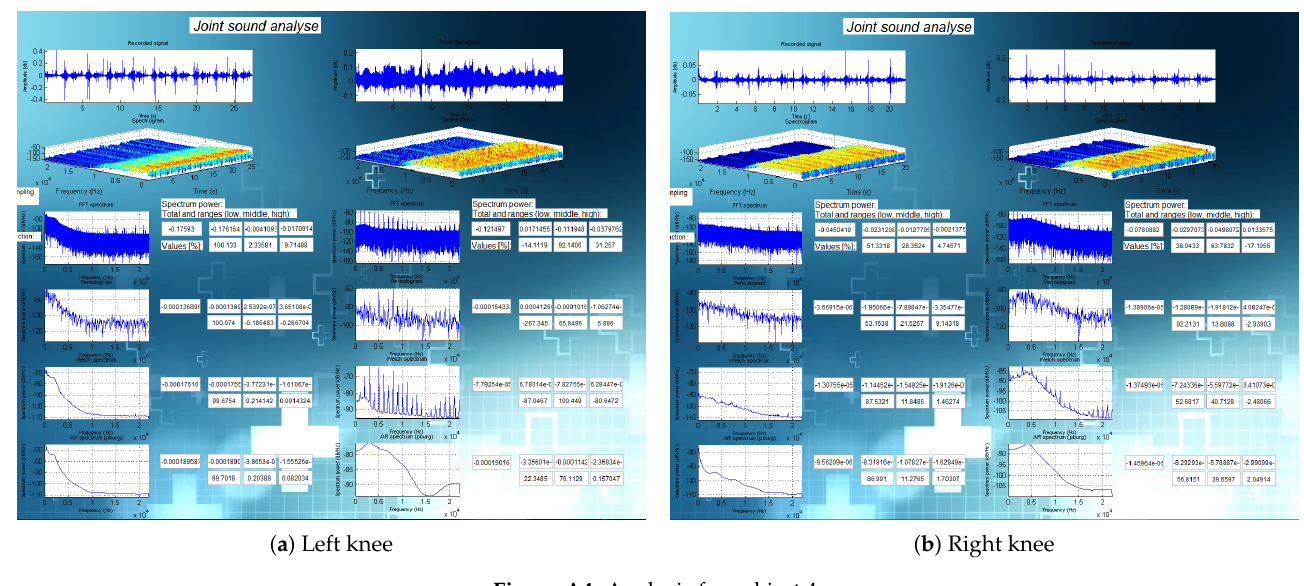
Figure A4. Analysis for subject 4. 5. gender: Male, age: 23, height: 187 cm, body mass: 70 kg, lifestyle: Standing, physical condition: Average, knee injuries: No, other remarks: Gym (Figure A5);